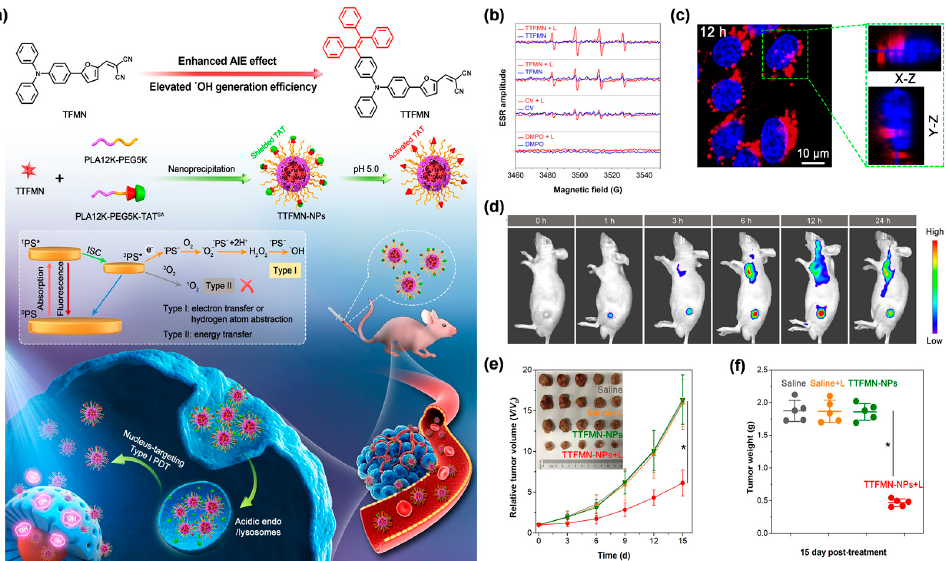
Figure 5. ( a ) Illustration of molecular design principle, nanotheranostics fabrication, and its appli- cation in nucleus-targeted type I photodynamic cancer treatment. ( b ) ESR analysis for OH • genera- tion of TTFMN and TFMN after white light irradiation (200 mW/cm 2 ). ( c ) CLSM images of nuclear targeting delivery of TTFMN-NPs (2 µg/mL TTFMN) after incubation with 4T1 cells for 12 h. The blue color represents the fluorescence of Hoechst 33342 for locating cell nucleus and the red color represents the fluorescence of TTFMN-NPs. ( d ) Time-dependent in vivo FLI of tumor-bearing mice after injection with TTFMN-NPs. ( e ) The growth curves of tumors in different treatment groups ( n = 5, * p < 0.001). ( f ) The tumor weights of mice after treatments for 15 days ( n = 5, * p < 0.001). Re- printed with permission from [61], copyright 2021, Wiley-VCH.